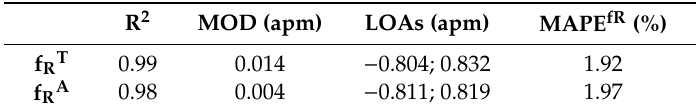
Table 2. Performance of the smart textile in respiratory monitoring: results of Bland-Altman analysis, linear regression and MAPE fR .